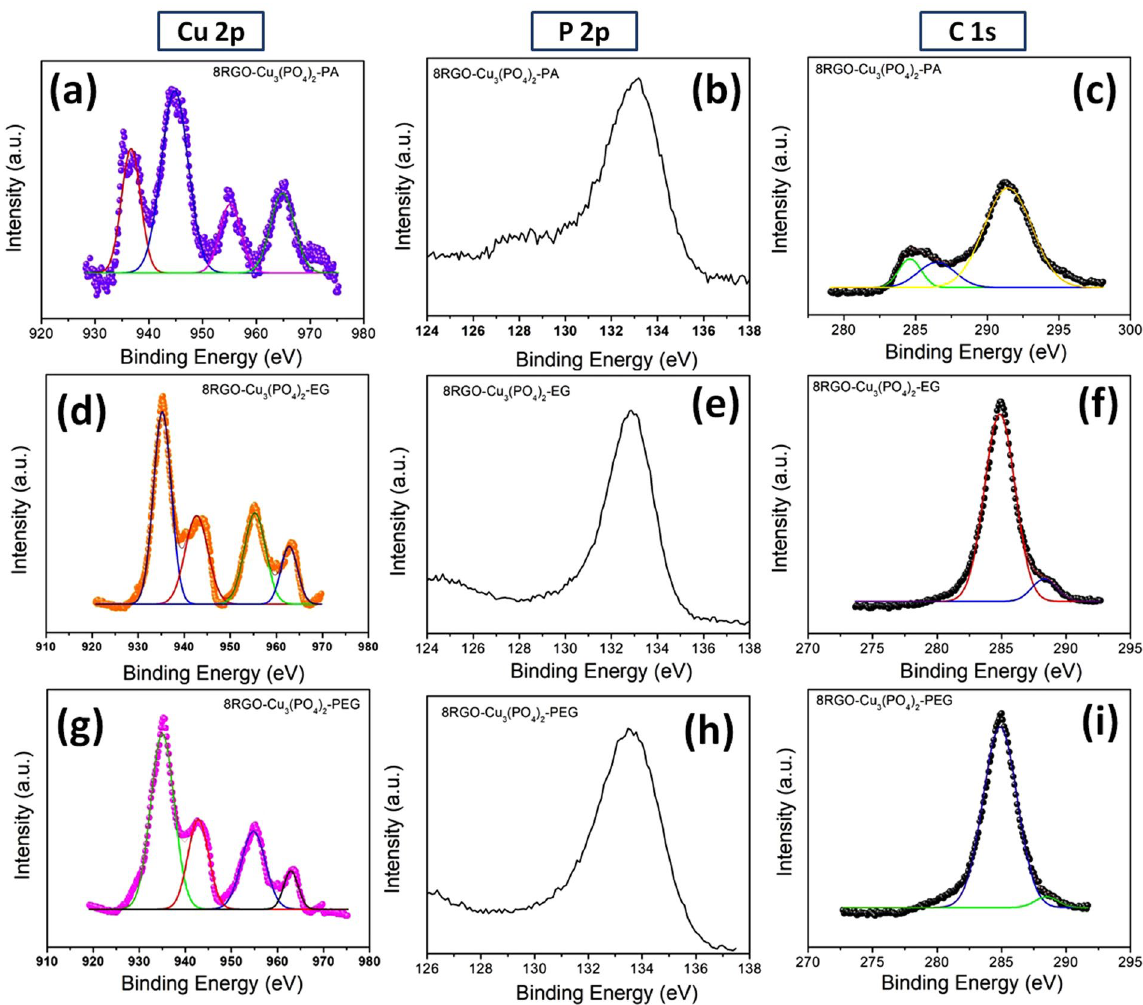
Figure 10. XPS survey spectra of 8RGO-Cu 3 (PO 4 ) 2 -PA ( a ) Cu 2p ( b ) P 2p (gain the same elemental investigation) C 1 s, 8RGO-Cu